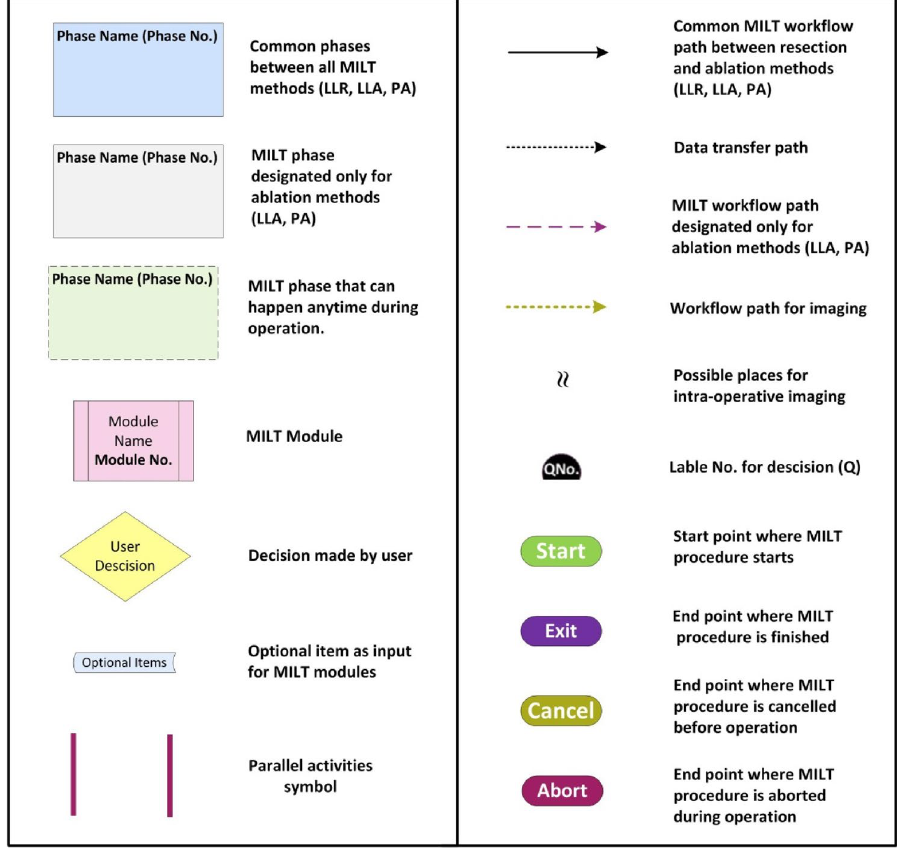
Figure 5. Explanation of the symbols and arrow styles used in Figs. 3 and